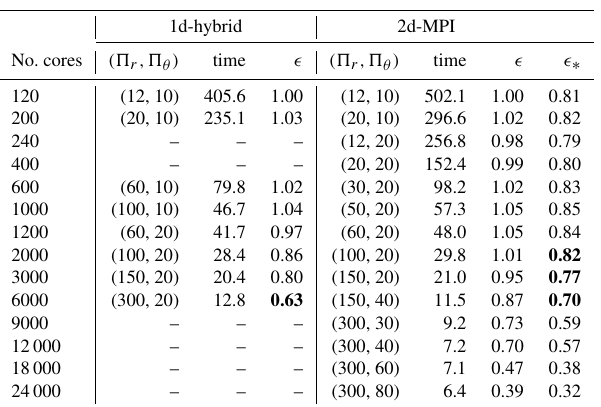
Figure 7. Strong scalability for the 1d-hybrid and 2d-MPI imple- mentations of MagIC for 100 time steps of the dynamo benchmark using N r = 301 and N θ = 960. Table 2. Parallel efficiency and cross-efficiency of the 1d-hybrid and 2d-MPI implementations, detailing (cid:53) r and (cid:53) θ as well as the main runtime in seconds. The bold font highlights values of